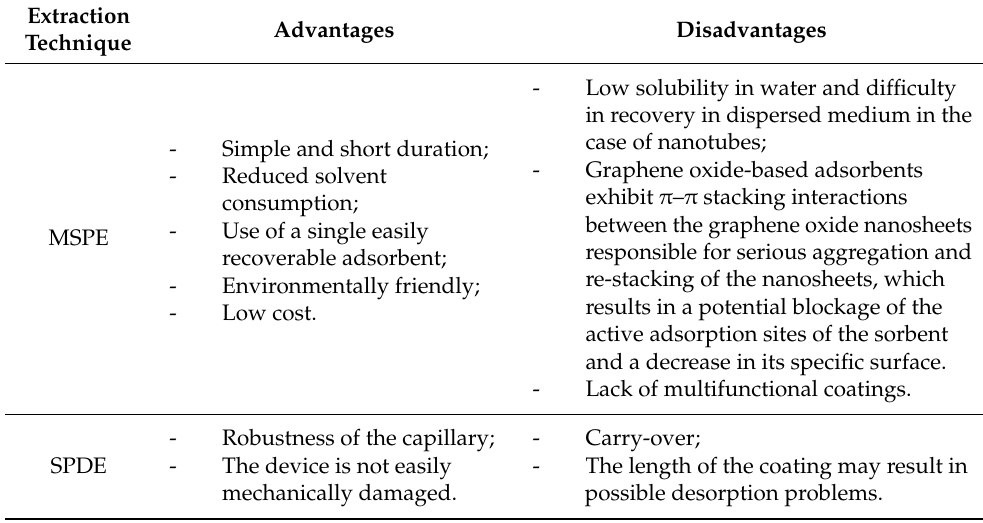
Table 8. Advantages and disadvantages of the MSPE and SPDE